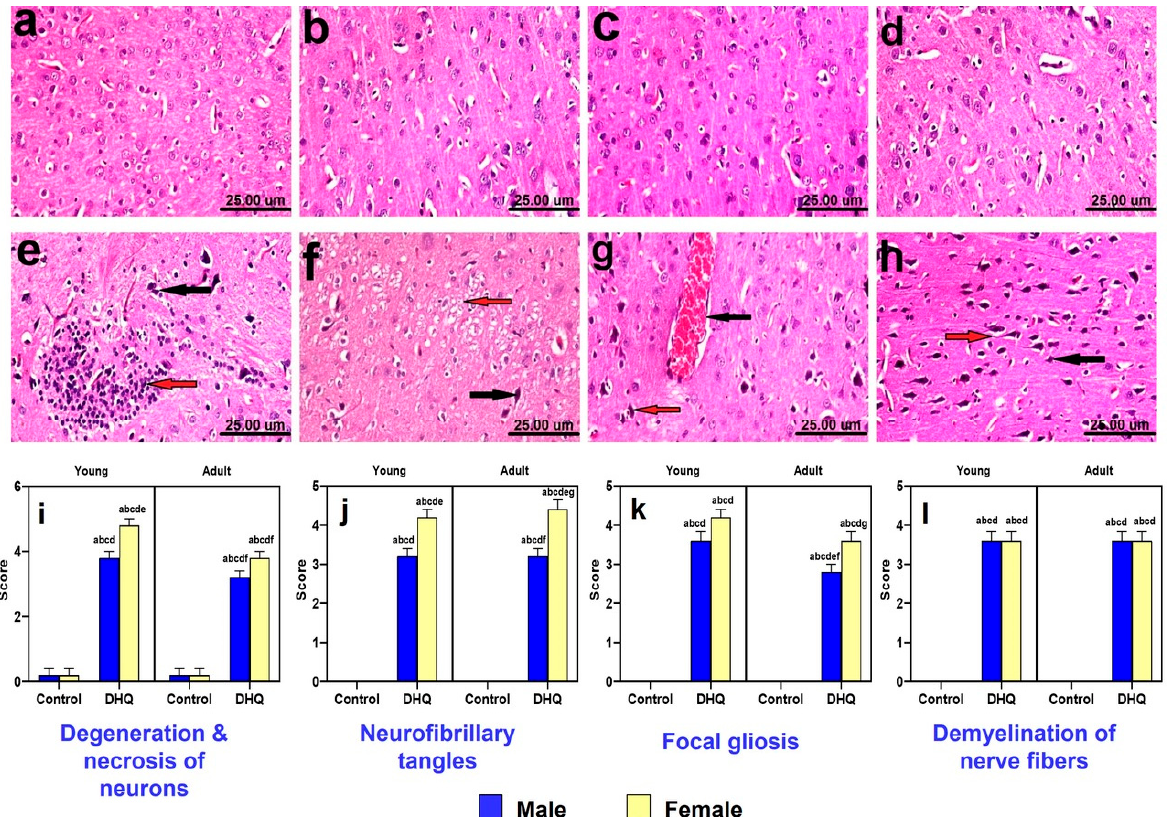
Figure 4. Photomicrograph of hematoxylin and eosin-stained cerebral cortices tissue sections of: ( a – d ) control rats, ( a ) young male, ( b ) young female, ( c ) adult male, and ( d ) adult female, showing normal histological picture. ( e ) DHQ young male showing shrunken necrotic neurons with pyknotic nuclei (black arrow) and focal gliosis (red arrow). ( f ) DHQ young female showing necrosis of neurons (black arrow) and demyelination of nerve fibers (red arrow). ( g ) DHQ adult male showing congestion of cerebral blood vessels (black arrow) and necrosis of neurons with neuronophagia (red arrow). ( h ) DHQ adult female showing massive neuronal degeneration (black arrow) with formation of neurofibrillary tangles (red arrow) (scale bar 25 um). Graphical representation of histopathological scores for ( i ) degeneration and necrosis of neurons, ( j ) neuro fibrillary tangles, ( k ) focal gliosis, and ( l ) demyelination of nerve fibers. Each bar with a vertical line represents the mean ± S.D. of 5 rats per group. a vs. control young male, b vs. control young female, c vs. control adult male, d vs. control adult female, e vs. treated young male, f vs. treated young female, and g vs. treated adult male using three-way ANOVA followed by Tukey’s post hoc test; p < 0.05. DHQ;